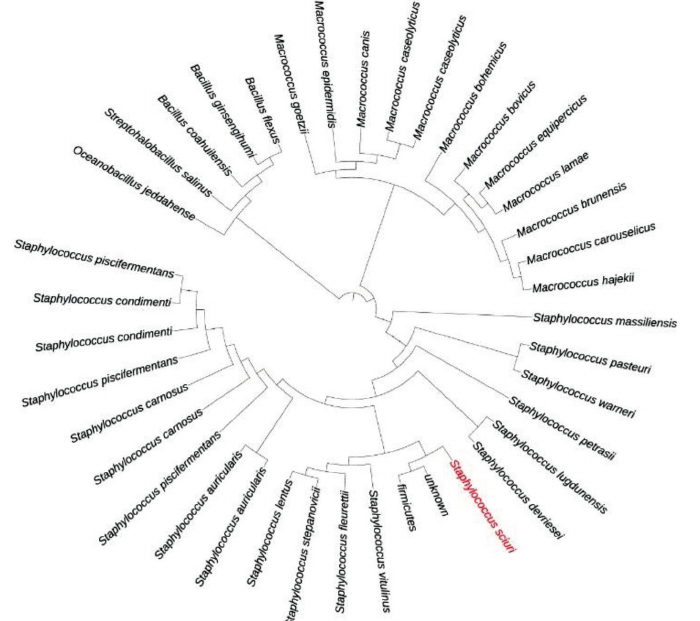
Fig. 1. Phylogenetic analysis of the Staphylococcus sciuri , isolates with different S taphylococcus strains from